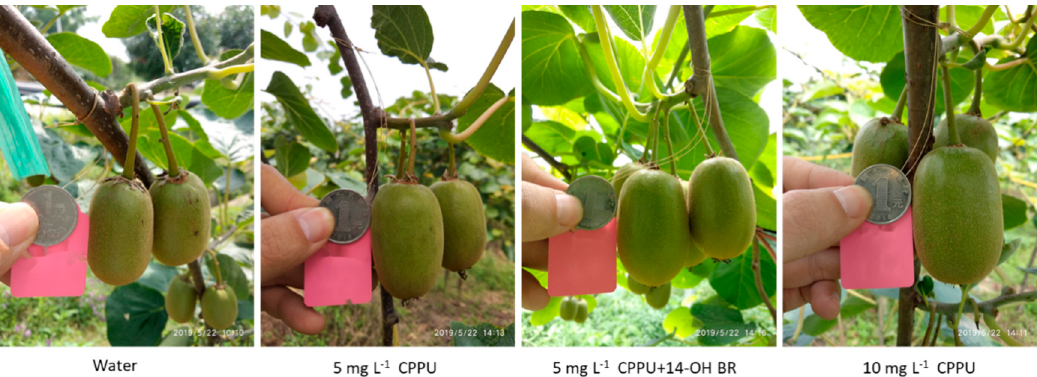
Figure 3. The phenotype of kiwifruit ( Actinidia chinensis ) ‘Donghong’ throughout fruit development. Coin diameter= 30 mm.